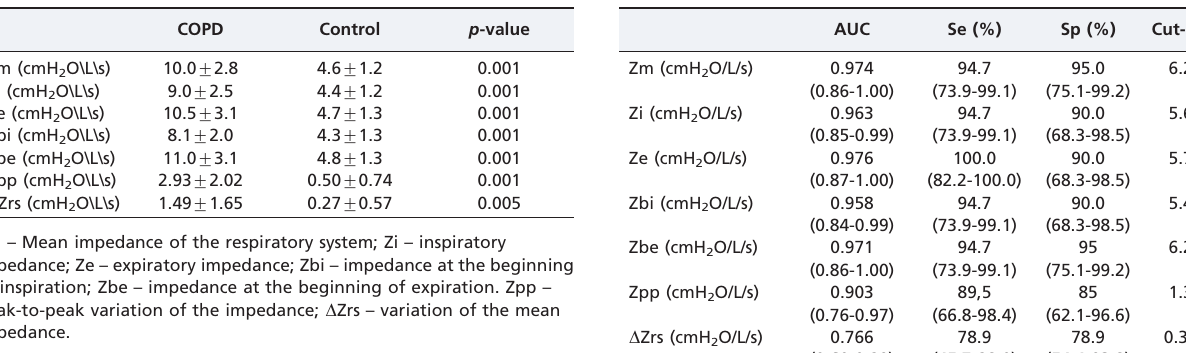
Table 2 - Comparative analysis between COPD and control subjects considering the impedance in different phases of the ventilatory cycle.